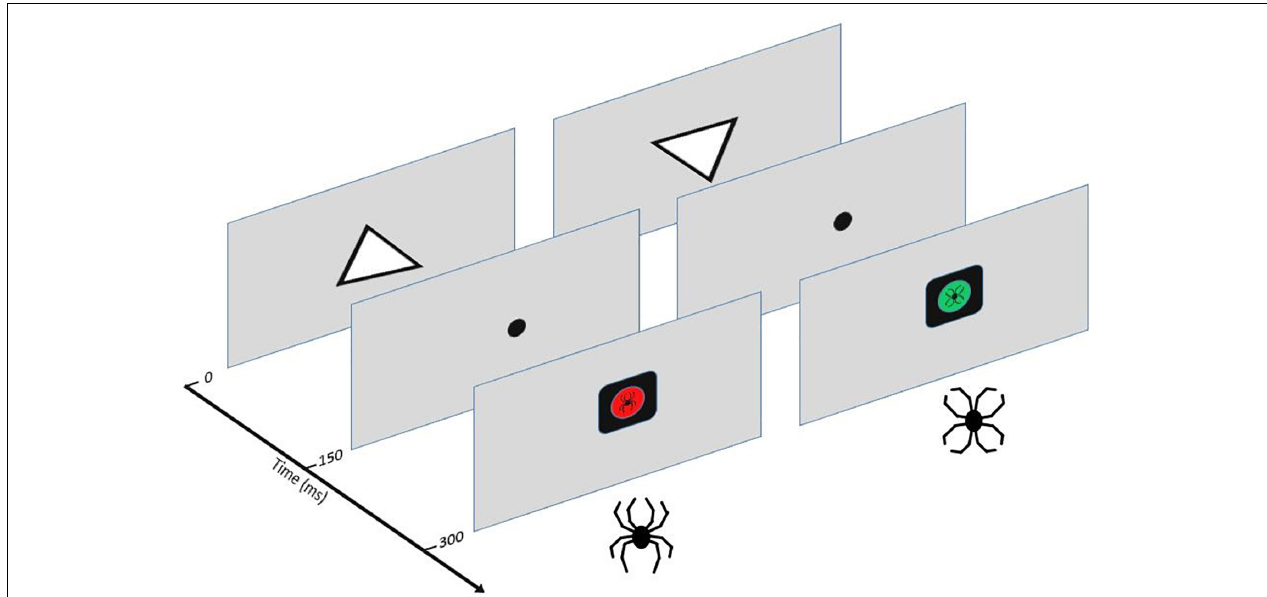
FIGURE 1 | The Executive RT Test (Hartikainen et al., 2010b). Participants were seated in front of a computer screen at one meter in a sound-attenuated room. Subjects were required to respond as fast and accurately as possible to the orientation of a triangle using their middle or index finger in a Go-trial indicating the triangle was pointing up or it was pointing down, respectively. In a NoGo-trial, subjects were supposed to withhold from responding. A trial started with an upright or inverted white triangle presented in the middle of the screen for 150 ms. After the onset of the triangle, a fixation dot appeared for 150 ms. This was followed by a black square with a colored circle and an emotional figure inside it. The colored circle and the emotional figure were response cues. There were two possible response sets: the participants were either asked to pay attention to the color (red or green) and ignore the emotional figures (flower or spider) as task-irrelevant distractors or pay attention to the emotional figures and ignore the colors. The stimuli (color or emotional figure) attended to indicated the rule for responding, e.g., when color was attended to the red-color indicated a Go-trial and the green-color a Nogo-trial or vice versa. When the emotional figure was attended to the spider figure indicated a Go-trial and the flower a Nogo-trial or vice versa. In case of a Go-trial, participants indicated the orientation of the previously presented triangle by pressing a button on a response pad. The emotional stimuli were black-line drawings of a spider (threat-related emotional stimulus) and a flower (emotionally neutral stimulus) constructed the exact same line elements as the spider but in a different configuration. This allowed control for the impact of low-level properties of visual stimuli, like color, contrast, and complexity.